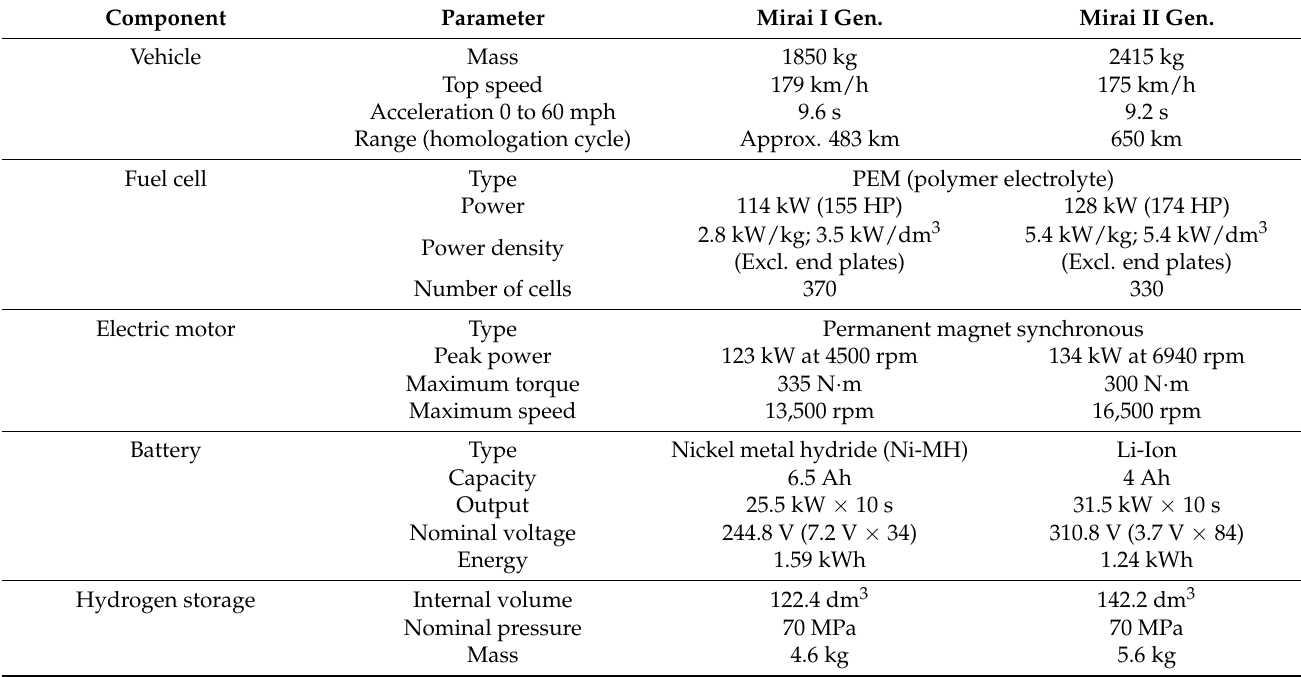
Table 1. Toyota Mirai powertrain system [8,9,15].